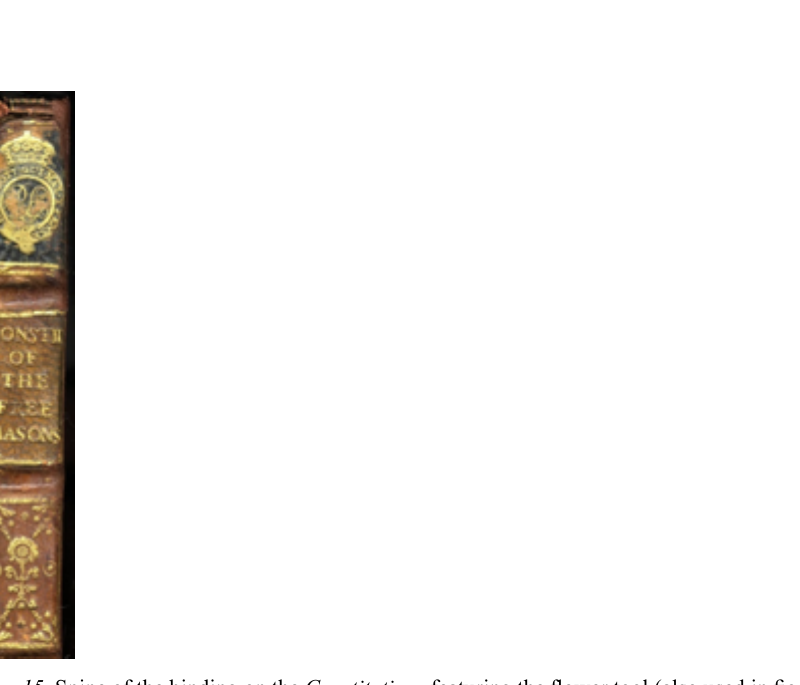
Fig. 15. Spine of the binding on the Constitutions featuring the flower tool (also used in fig. 14). Copyright and reproduced by permission of the Museum of Freemasonry,